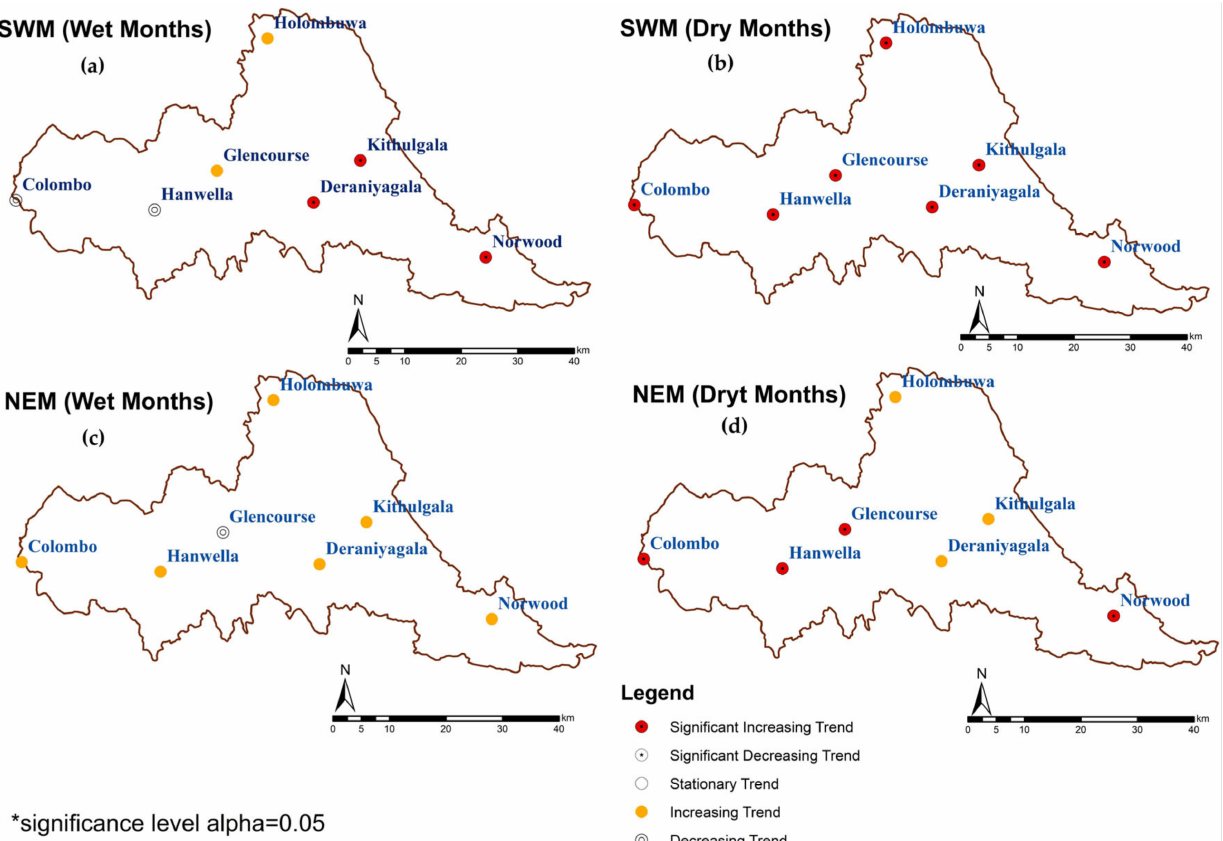
Figure 6. Trend of seasonal dry and wet months from 1951 to 2019 in the KRB. ( a ) Long-term trend of SWM (wet months), ( b ) long-term trend of SWM (dry months), ( c ) long-term trend of NEM (wet months), and ( d ) long-term trend of NEM (dry